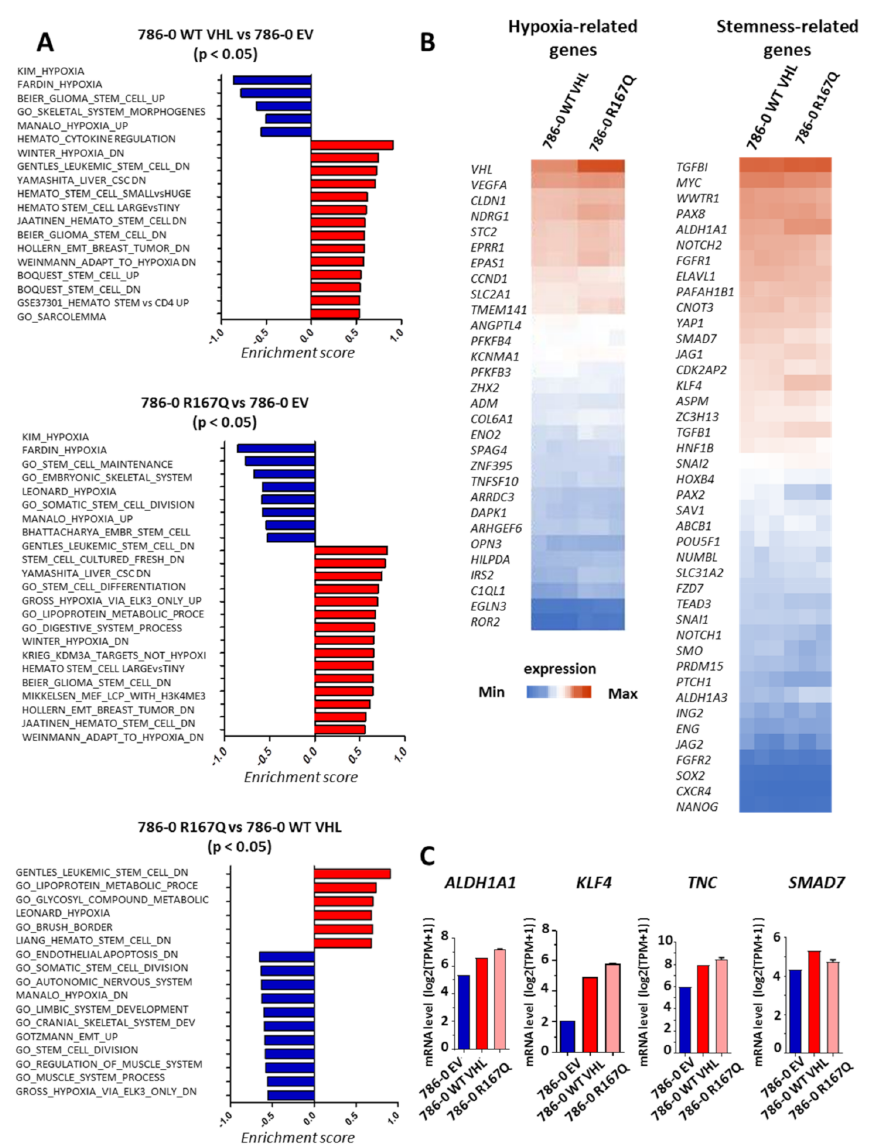
Figure 4. Hypoxia and stemness pathways are enriched in 786-0 VHL-R167Q, reflecting an increase in cell plasticity. ( A ): Differentially enriched gene sets nominated from GSEA analysis in 786-0 WT VHL vs. 786-0 EV, 786-0 R167Q vs. 786-0 WT VHL, 786-0 R167Q vs. 786-0 EV classified by enrichment scores. A positive score indicates enrichment, whereas a negative score indicates enrichment in the indicated conditions. ( B ): Heatmap displaying log2-transformed expression levels of a panel of hypoxia-related genes and stemness-related genes in 786-0 WT VHL and 786-0 R167Q. Heatmaps comparing the three models are presented in Figure S1. ( C ): mRNA expression of ALDH1A1 , KLF4 , TNC , and SMAD7 from RNA-Seq analysis in the three 786-0 cell lines. The bar graphs show log2- transformed